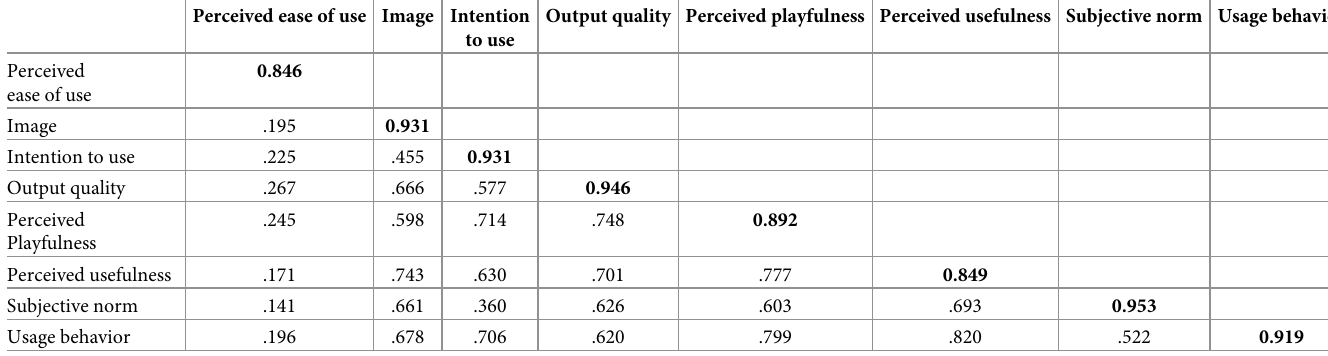
Table 5. Discriminant validity of the latent constructs for physical